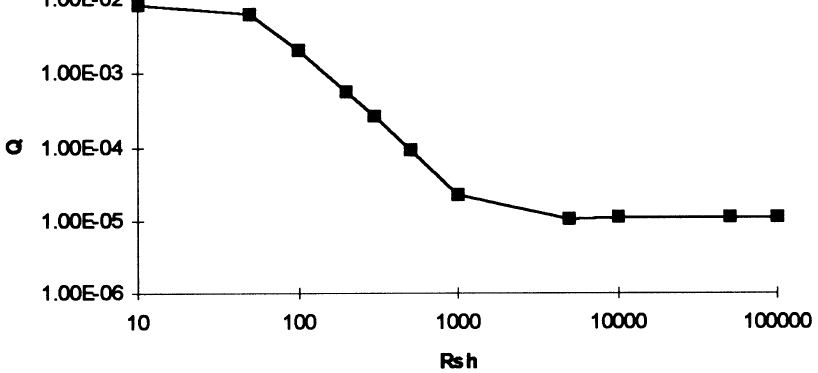
FIGURE 2 Q function versus the shunt resistance value R sh for a theoretical characteristic ð R s ¼ 5 O ; A ¼ 1 : 7 ; I o1 ¼ 10 (cid:3) 12 A ; I o2 ¼ 10 (cid:3) 9 A Þ